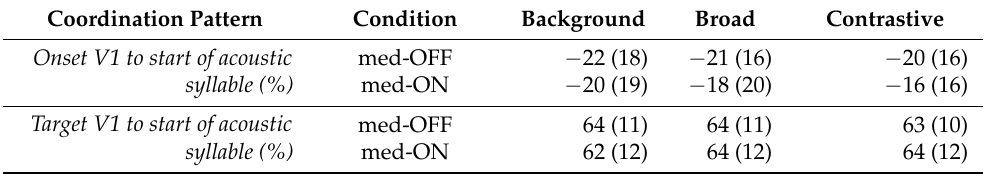
Table 5. Acoustic–articulatory relations: Coordination patterns (mean and sd) between the vocalic tongue body movement and the acoustic CV syllable. Negative values indicate that the landmark lies before the syllable. Positive values indicate an achievement within the acoustic syllable. Coordination Pattern